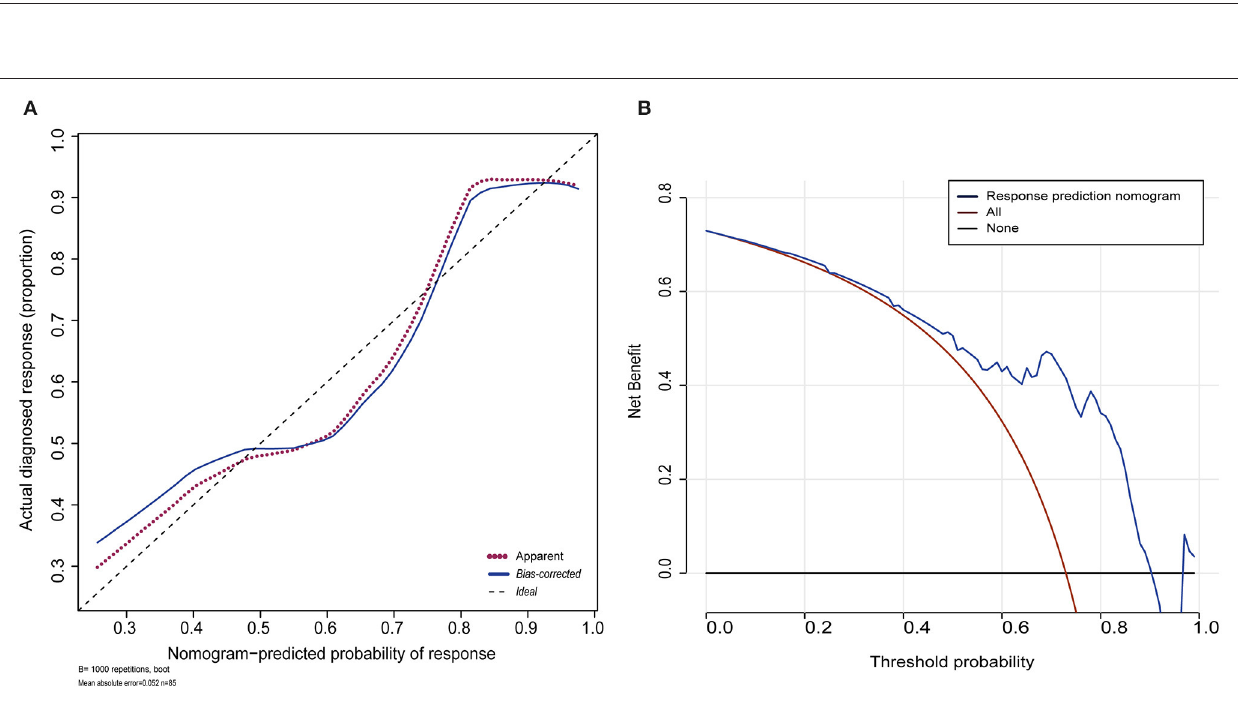
FIGURE 4 | Calibration plot for the nomogram and decision curve analysis of the logistic model. (A) Calibration plot for the nomogram. The dotted black line indicates the location of the ideal nomogram, in which the predicted and actual probabilities are identical. The dotted red line indicates the apparent accuracy of the nomogram without correction for overfitting. The blue solid line represents the bootstrap-corrected nomogram. (B) Decision curve analyses (DCA) demonstrating the net benefit associated with use of the response nomogram with regards to predicting a response to treatment. The y -axis represents the net benefit. The red line represents the treat-all-patients scheme. The black line represents the treat-none scheme. The blue line represents the predictive nomogram scheme. The decision curve shows that if the threshold probability is 1–91%, using this nomogram in the current study to predict response adds more benefit than an intervention-in-all-patients scheme or an intervention-in-none